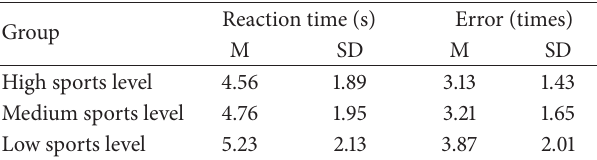
Table 1: Visual image operation performance of subjects with different sports levels.